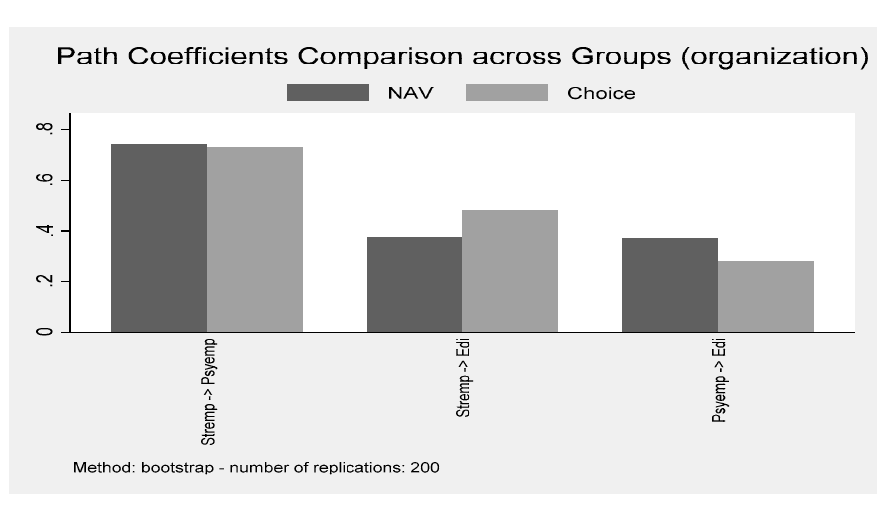
Figure 2. Path coefficients comparison across groups. Figure 2. Path coe ffi cients comparison across